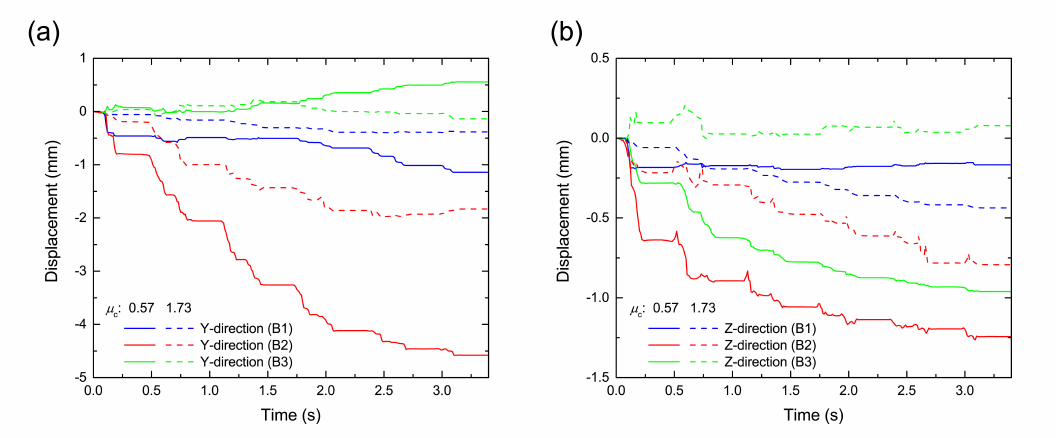
Figure 8. Time variations of displacements in ( a ) the lateral y -direction and ( b ) the vertical z -direction for each ballast particle located at B1, B2 and B3. The solid and dashed lines represent the results with frictional coefficients ( µ c ) of 0.57 and 1.73, respectively. These figures correspond to the time history of pressure shown in Figure 5, where the number of passing cars was